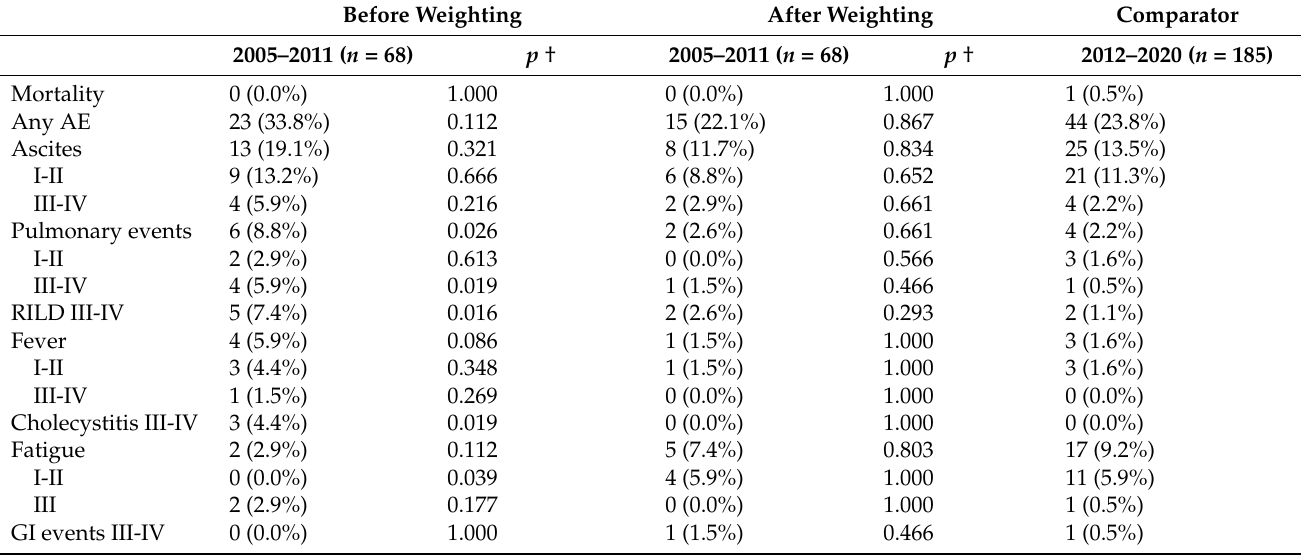
Table 3. Occurrence of adverse events within 1 month from transarterial radioembolisation, divided by treatment period, and before and after entropy balance reweighting. This table points out what the mortality and morbidity of patients treated in the first period would have been with the increased expertise and personalised dosimetry of the more recent